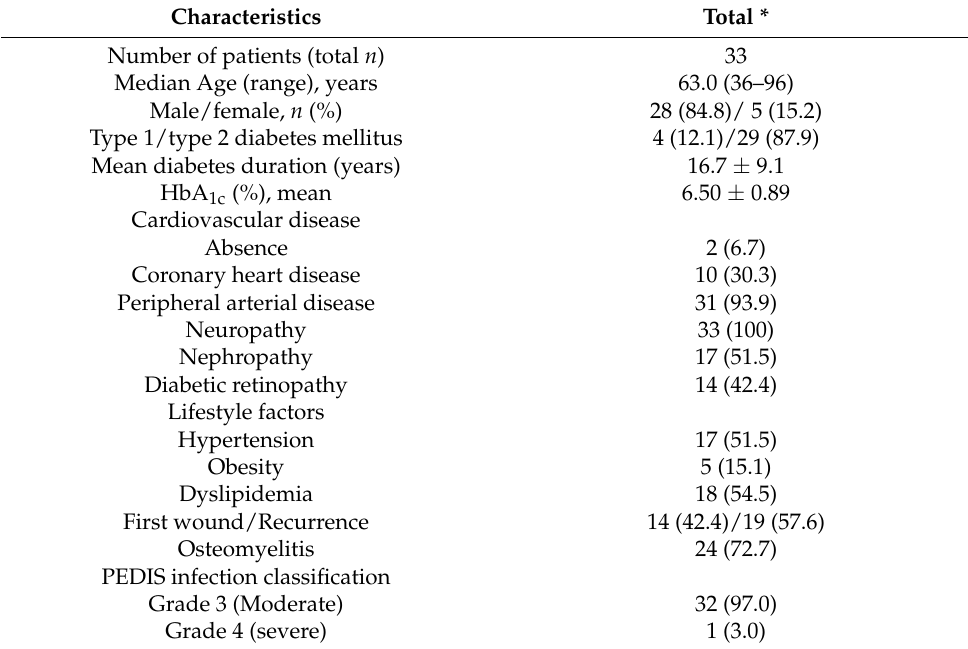
Table 1. Demographic and clinical characteristics of the studied